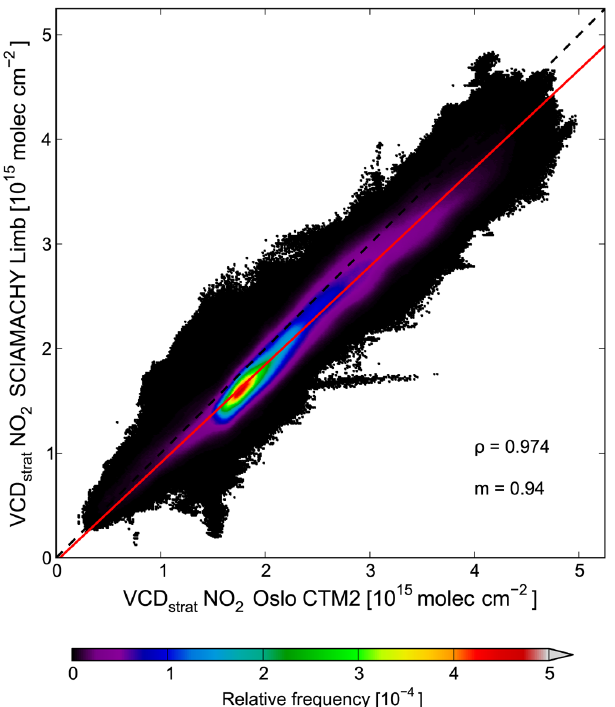
As comparison, we show the “stratospheric” vertical column derived from SCIAMACHY nadir measurements as First, it is noticeable that the zonal variability of SCIAMACHY limb measurements and Oslo CTM2 simulations is remarkably similar (see Fig. 10, top). However, the simulated stratospheric 375 columns are often larger than the measured values, which is also shown by the linear regression of the two datasets (cf. Fig. 8). The two stratospheric datasets agree reasonably well with the nadir measurements in unpolluted regions (see Fig. 10, top).